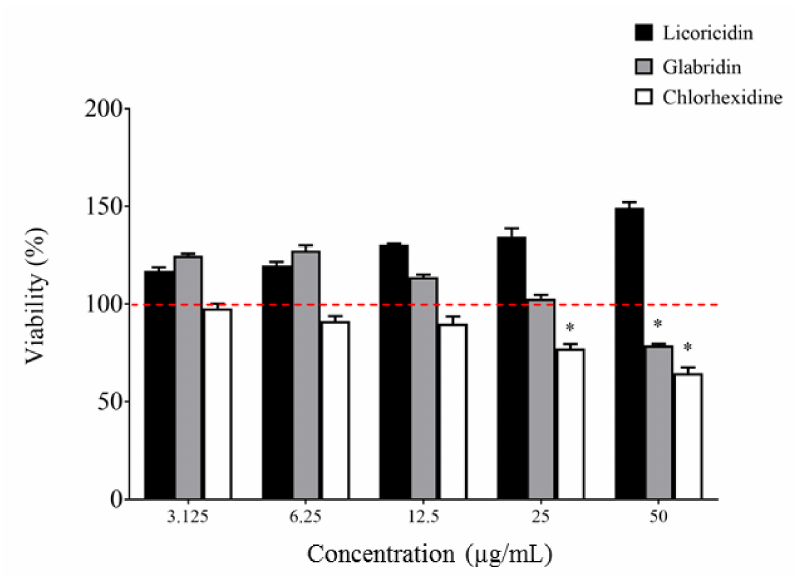
Figure 5. Effect of licoricidin and glabridin on the viability of oral keratinocytes. Cell viability was monitored following a 2-h exposure to the compounds using a MTT (3-[4,5-diethylthiazol-2-yl]-2,5- diphenyltetrazolium bromide) colorimetric assay. The assays were carried out in triplicate, and the means ± standard deviations were calculated. *, significantly different ( p < 0.01) from the control (no